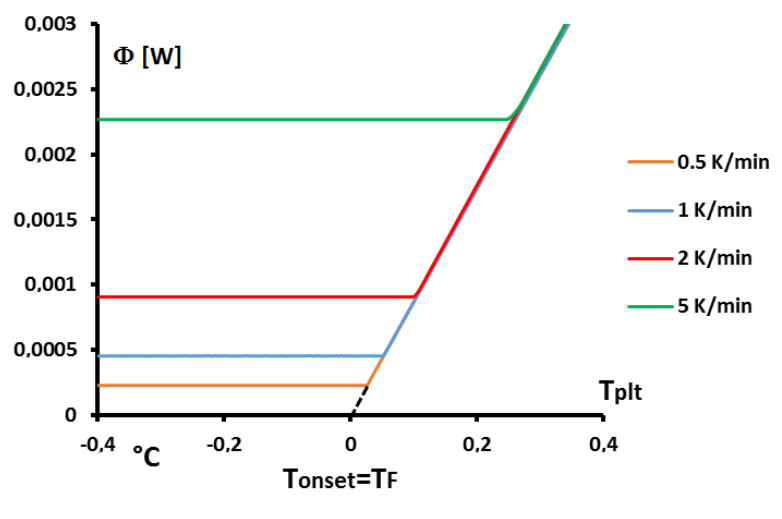
Figure 13. Drawing for the determination of T onset = T F in case of a calibration of the temperature with the zero